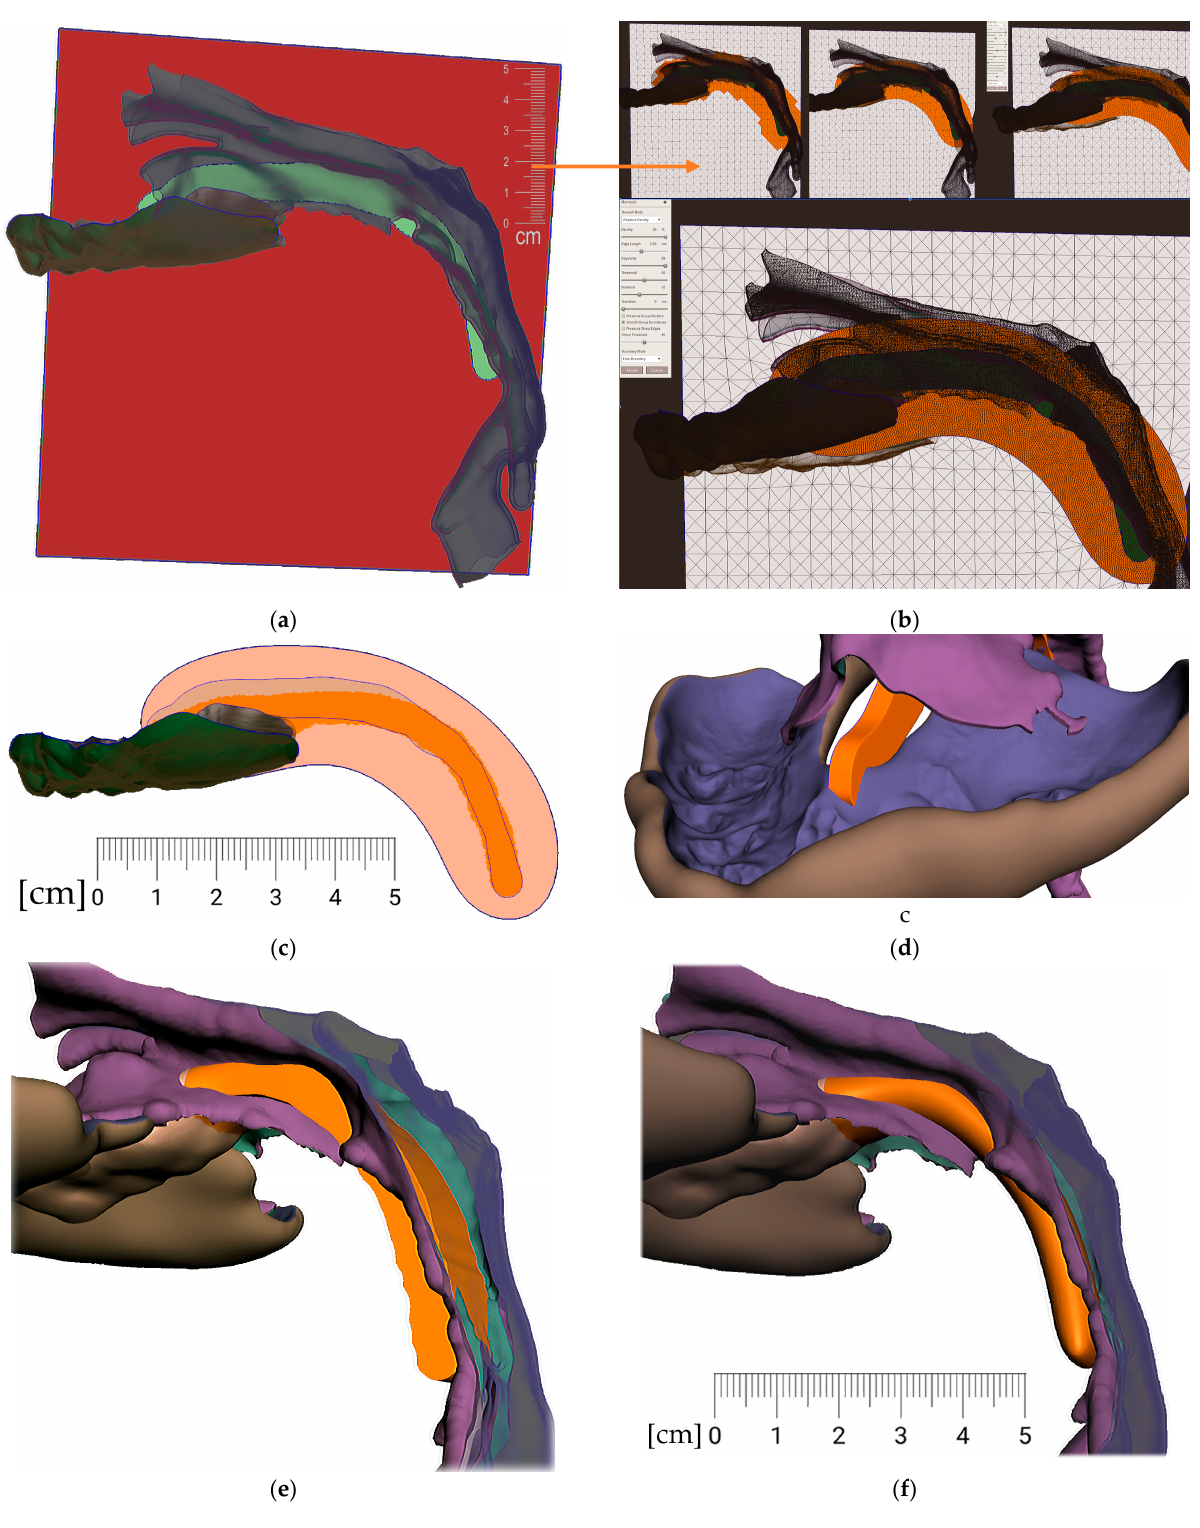
Figure 12. Pharyngeal part creation (the spur)—Spur profile design—Region definition: ( a ) import a Mesh primitive—2D plane; ( b ) select tool define region -> optimize boundaries—keystrokes “O”, “B” and Re-mesh to high density key strokes “R”; ( c ) select and delete irrelevant part of the plane; ( d ) Edit—Extrusion keystroke “D”; ( e ) extrude to desired width; ( f ) select all and keystroke “Ctrl+F” smooth.